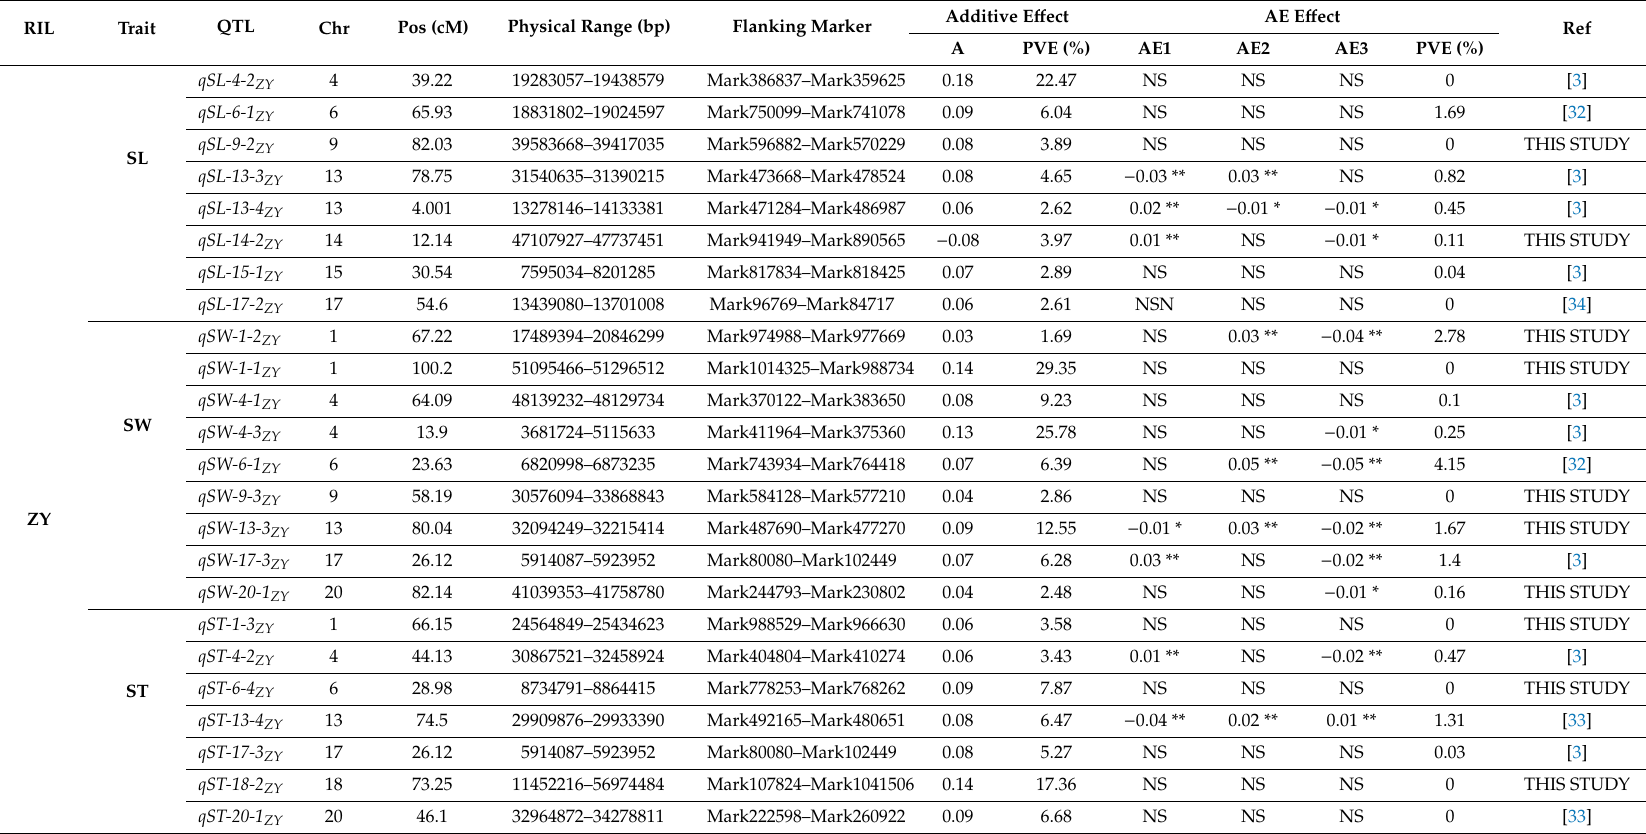
Table 3. Additive and additive x environment interaction e ff ects of QTLs associated with seed shape traits in two RIL